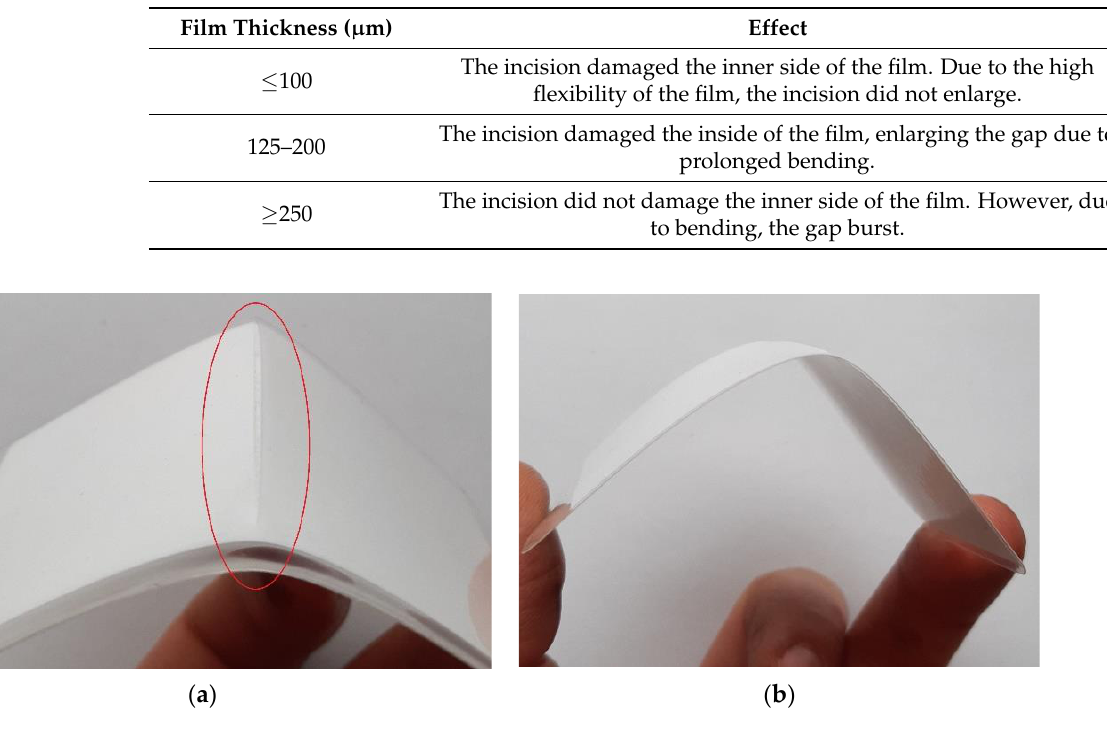
Figure 2. Samples tests: ( a ) i ncision test of a film with a thickness of 250 μm with a burst gap; ( b ) i ncision test of a film with a thickness of 100 μm , which does not enlarge the damage. ( b ) incision test of a film with a thickness of 100 µ m, which does not enlarge the damage.